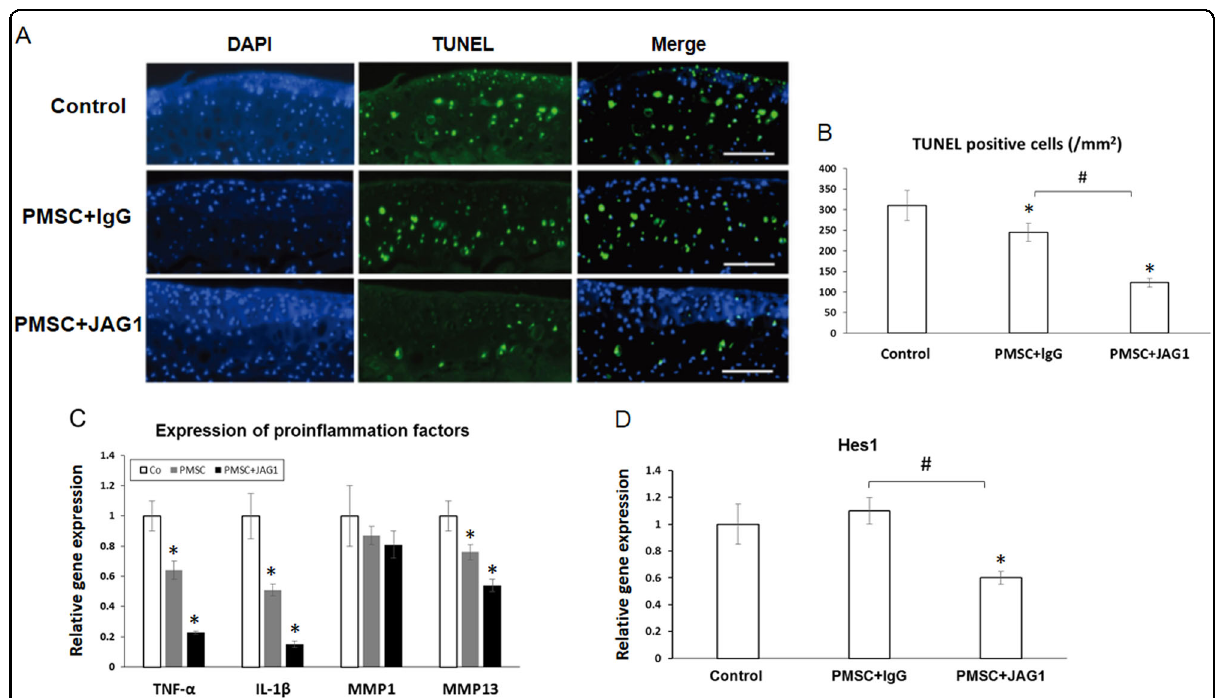
Fig. 6 JAG1 treatment inhibits chondrocyte apoptosis and in fl ammation in the mouse OA joint. a Top panel: The representative images of TUNEL staining of the tibia plateau from a control OA mouse injected with 8 µl PBS. Middle panel: The stained tibia plateau from a control OA mouse injected with 8 µl PBS containing 0.2 million PMSCs and lgG (10 µg/ml). Low panel: The stained tibia plateau from a control OA mouse injected with 8 µl PBS containing 0.2 million PMSCs and JAG1 (10 µg/ml). b Quanti fi cation of TUNEL-positive cells in areas of the stained tibia plateau ( n = 12). Data are the means ± SD (* p < 0.05 compared with control; # P < 0.05 between two groups). c Relative mRNA expression of proin fl ammation cytokines was analyzed by quantitative real-time PCR after synovial tissue obtained from OA mice was treated with PMSCs with or without JAG1 for 4 weeks. The data are the means ± SD (* p < 0.05 compared with control). d Relative mRNA expression of the Notch target gene Hes1 in synovial tissue was analyzed by quantitative real-time PCR. Data are the means ± SD (* p < 0.05 compared with control; # P < 0.05 between two